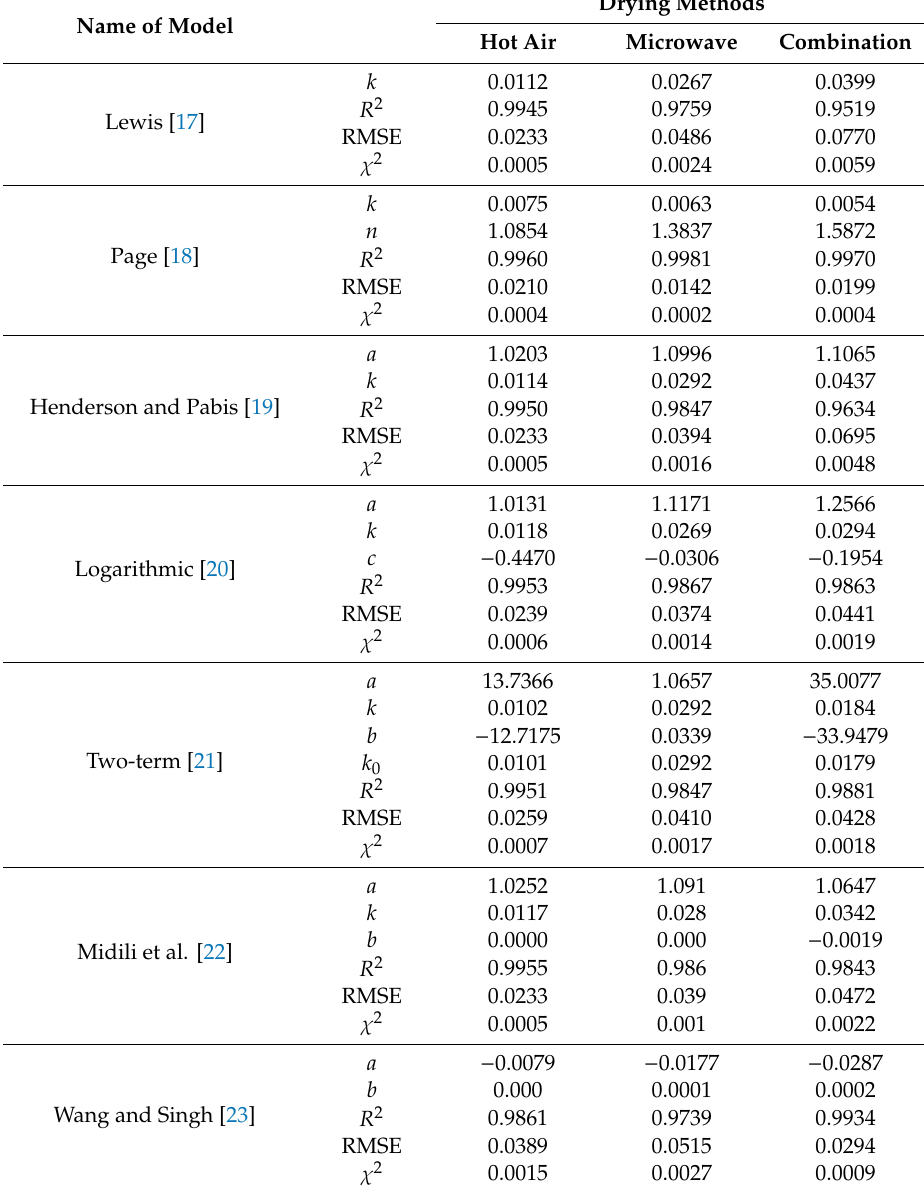
Table 3. The calculated coe ffi cients of the applied drying models for radish slabs. RMSE: root mean square error. Name of